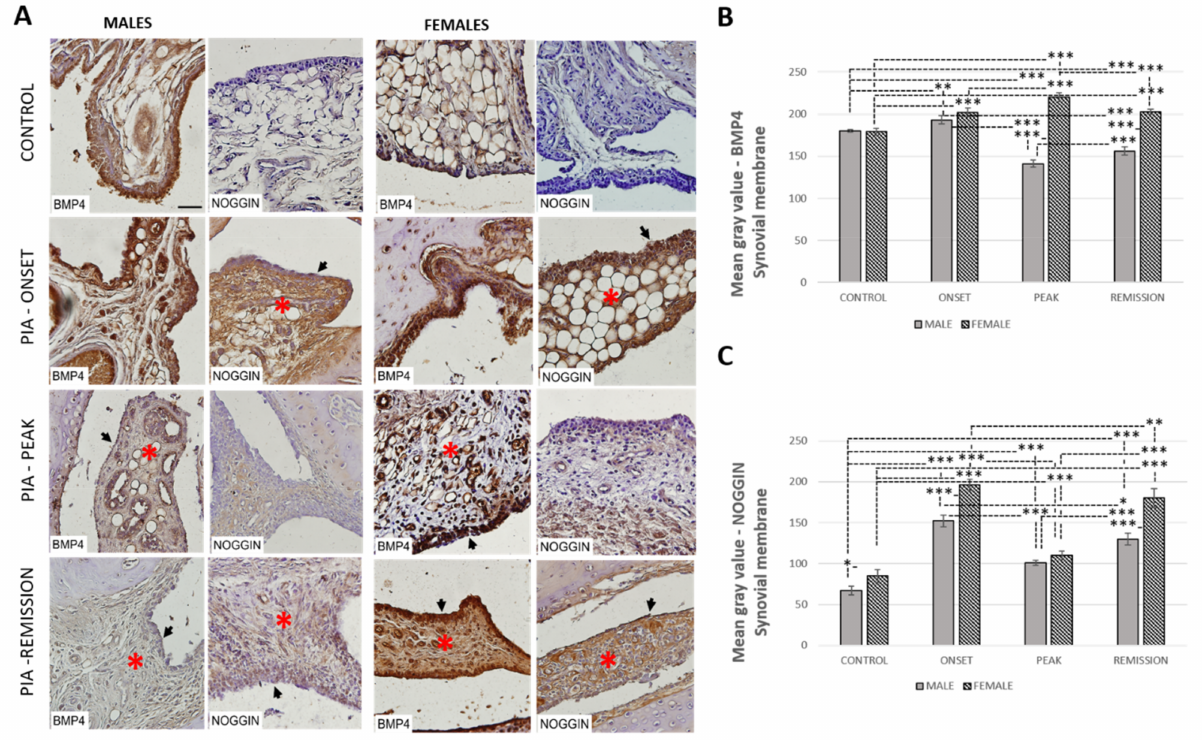
Figure 7. Pristane-induced arthritis upregulates BMP-4 and Noggin expression in synovial tissue in female rats more than in male rats. ( A ) Representative immunohistochemical pictures show staining with anti-BMP-4 and anti-Noggin antibodies in paraffin-embedded sections of metatarsophalangeal joints obtained from male and female DA rats: control (treated with saline); PIA onset (between 9th and 12th day after induction); PIA peak (between 16th and 20th day after induction); PIA remission (between 20th and 25th day after induction). BMP-4 is expressed in stromal cells and synovial lining cells. *gender differences in immunohistochemical staining of stroma; arrows: gender differences in immunohistochemical staining and proliferation of synovial lining cell layer. ( B , C ) BMP-4 and Noggin immunoreactivity in synovial tissue of metatarsophalangeal joints. Immunohistochemical staining quantification was performed using Cell F v3.1 software analysis on 12 regions of interest (3 slides/rat × 6 rats/group). Values are expressed as mean grey value ± SD ( N = 24). One-way ANOVA followed by the post hoc Scheff é test: * p < 0.05, ** p < 0.01 and *** p < 0.001. Scale bars indicate 50 µ